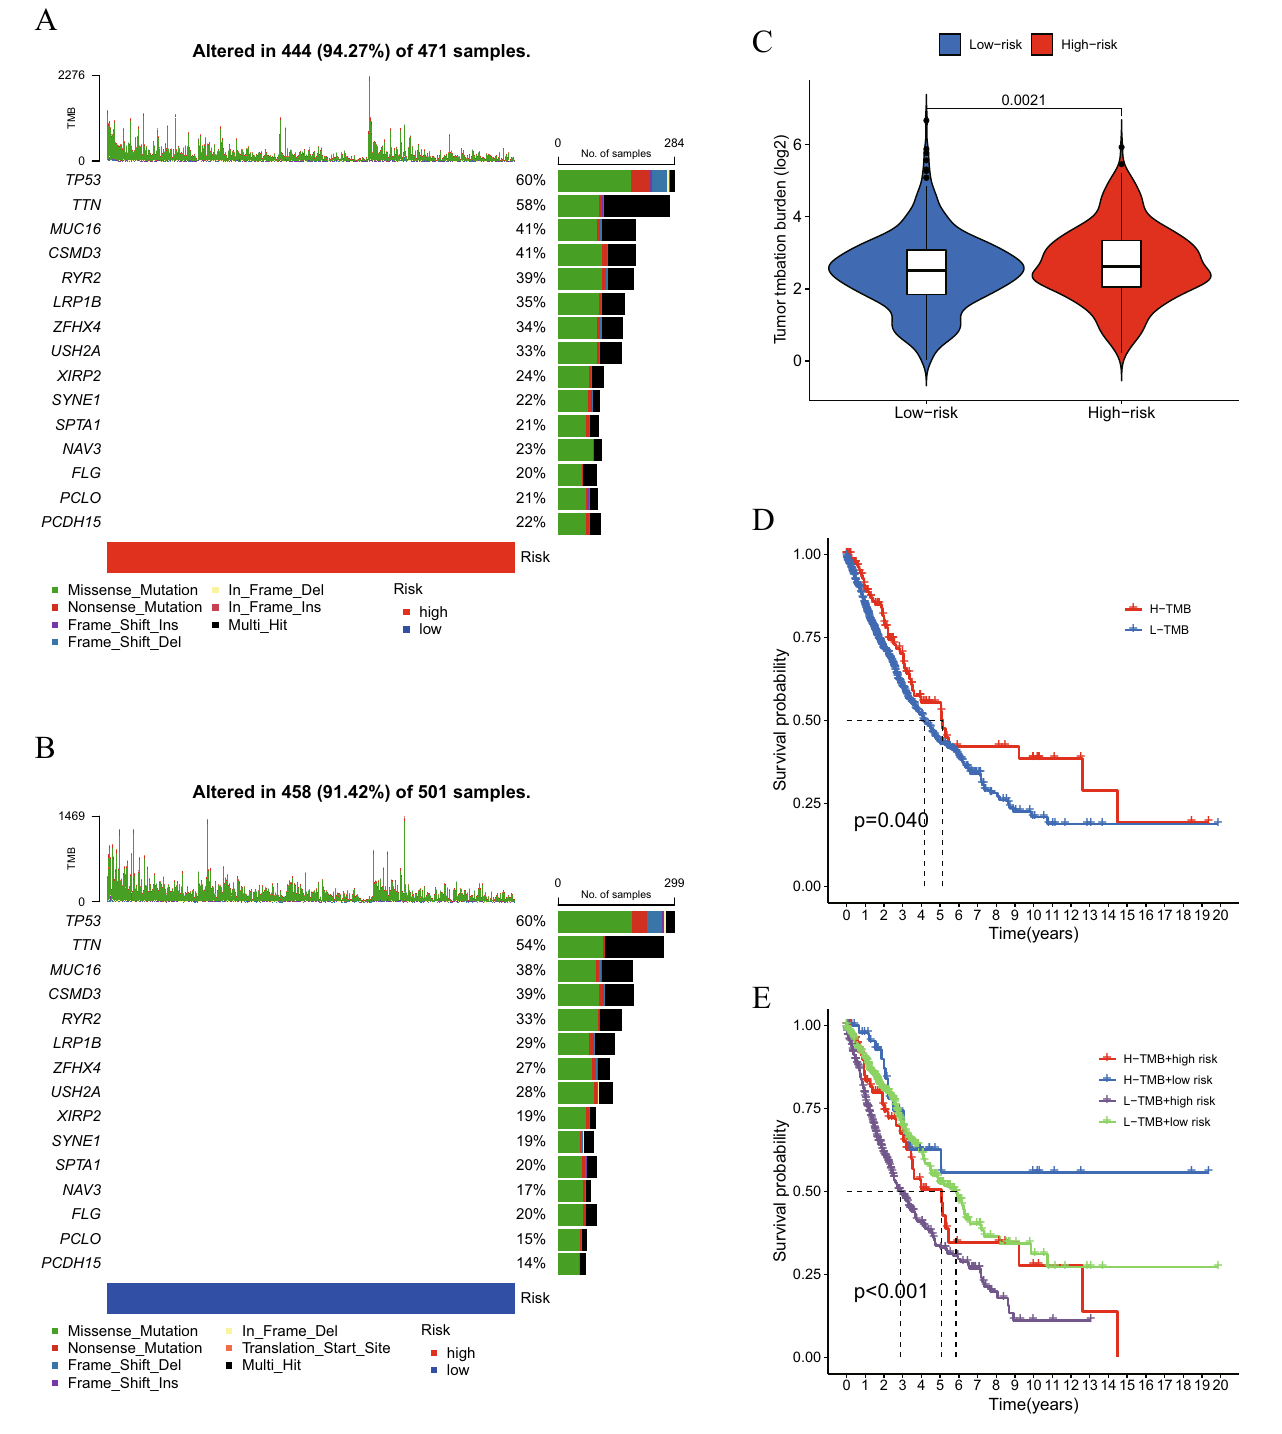
PCDH15PCLOFLGNAV3SPTA1SYNE1XIRP2USH2AZFHX4LRP1BRYR2CSMD3MUC16TTNTP53 SPTA1SYNE1XIRP2USH2AZFHX4LRP1BRYR2CSMD3MUC16TTNTP53 Figure 9. Mutation profile in patients with ( A ) high risk and ( B ) low risk. ( C ) Relationship between TMB and the cuproptosis-related lncRNA signature. ( D ) K-M curves in the high-TMB and low-TMB groups. ( E ) K-M curves in the high-TMB + high-risk, high-TMB + low-risk, low-TMB + high-risk and low-TMB + low- risk groups. K-M, Kaplan–Meier; lncRNA, long non-coding RNA; TMB, tumor mutation burden; OS, overall